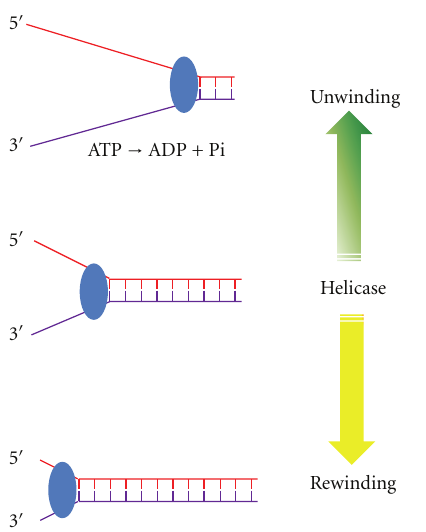
Figure 1: A model of helicase function to unwind or rewind double-stranded nucleic acid. Note that helicase (oval) repre- sents both translocation polarities; either ATP-dependent or ATP- independent for strand annealing activity has been observed in helicases (see Table